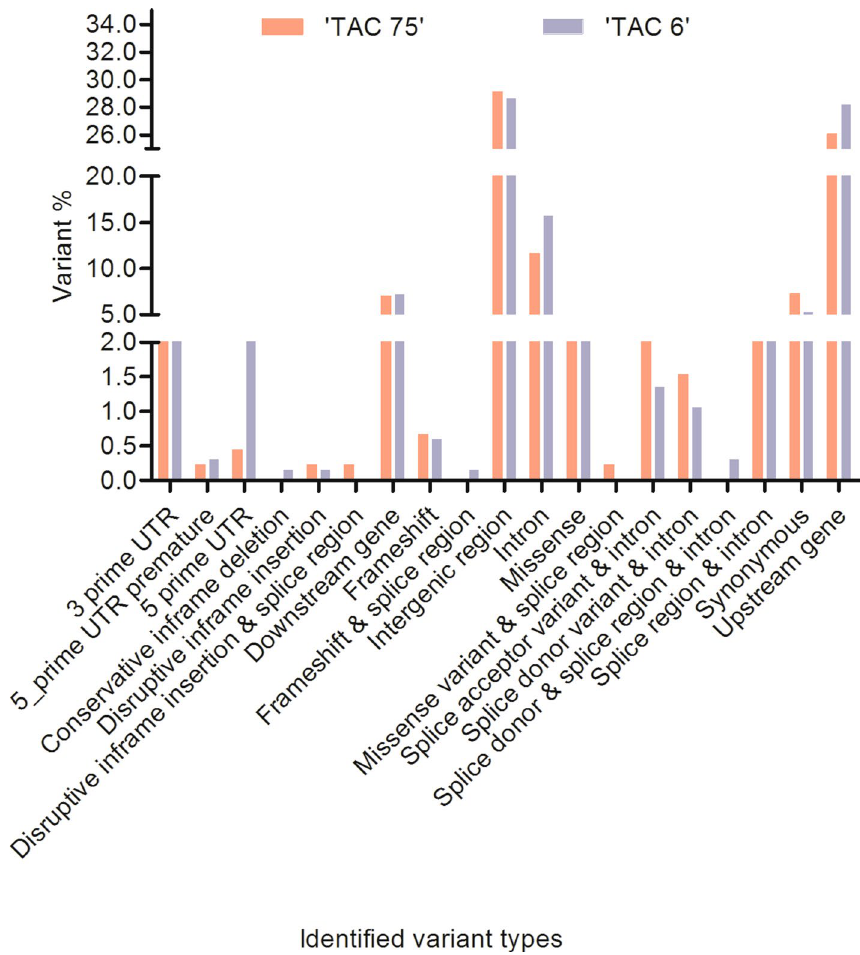
Figure 6. Percent distribution of different genetic variants in mutant lines ‘TAC 75’ and ‘TAC